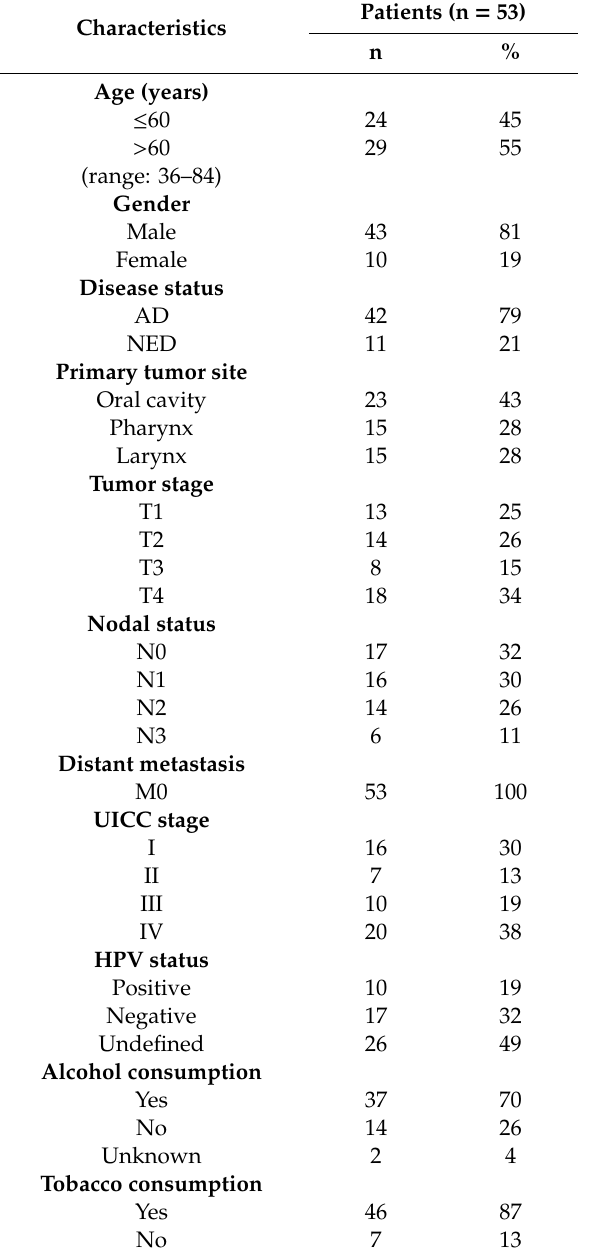
Table 1. Clinicopathological